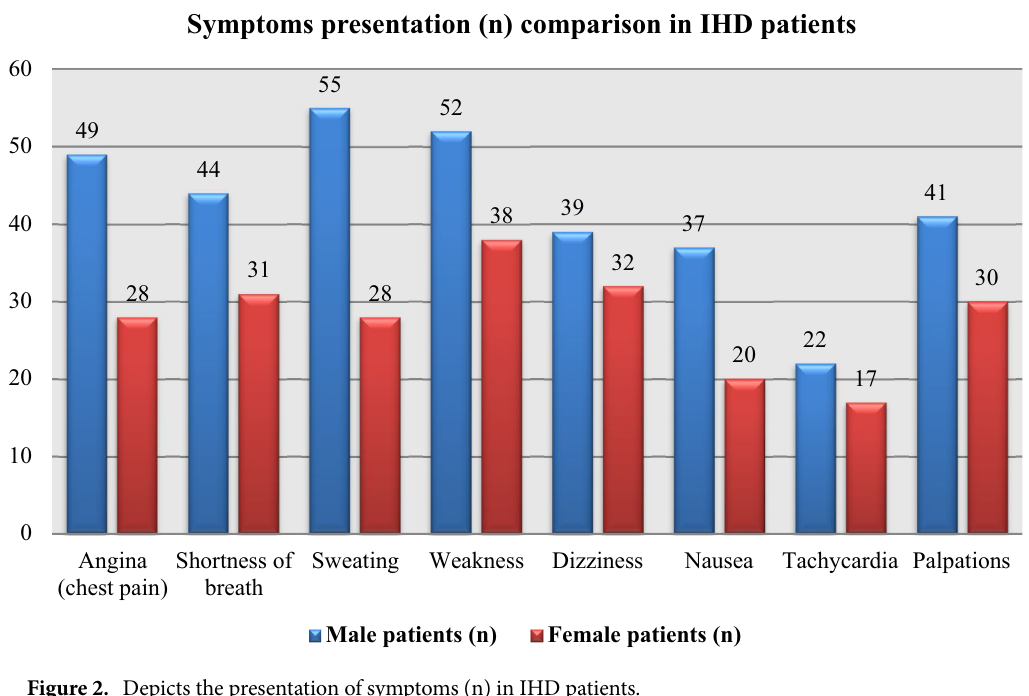
Figure 2. Depicts the presentation of symptoms (n) in IHD